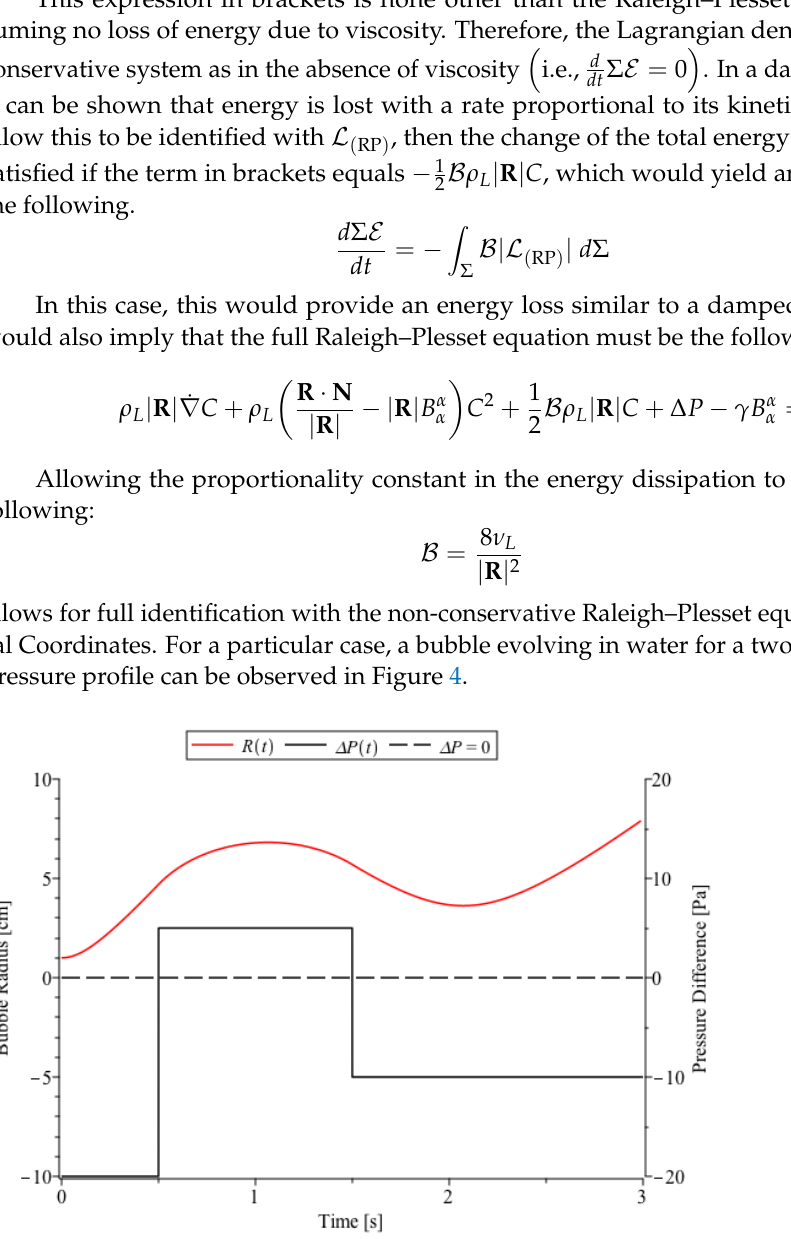
Figure 4. Numerical Solution of the Raleigh–Plesset Equation displaying the bubble radius ( red ) evolving in time R ( t ) , with units [cm] on the left axis. Physical parameters were chosen to model an immersion in water: a kinematic viscosity ν L = ( 10 − 6 ) m 2 /s, density ρ L = ( 10 3 ) kg/m 3 , and surface tension γ = ( 7.2 · 10 − 2 ) N/m. A test pressure difference is also displayed, which begins at − 20